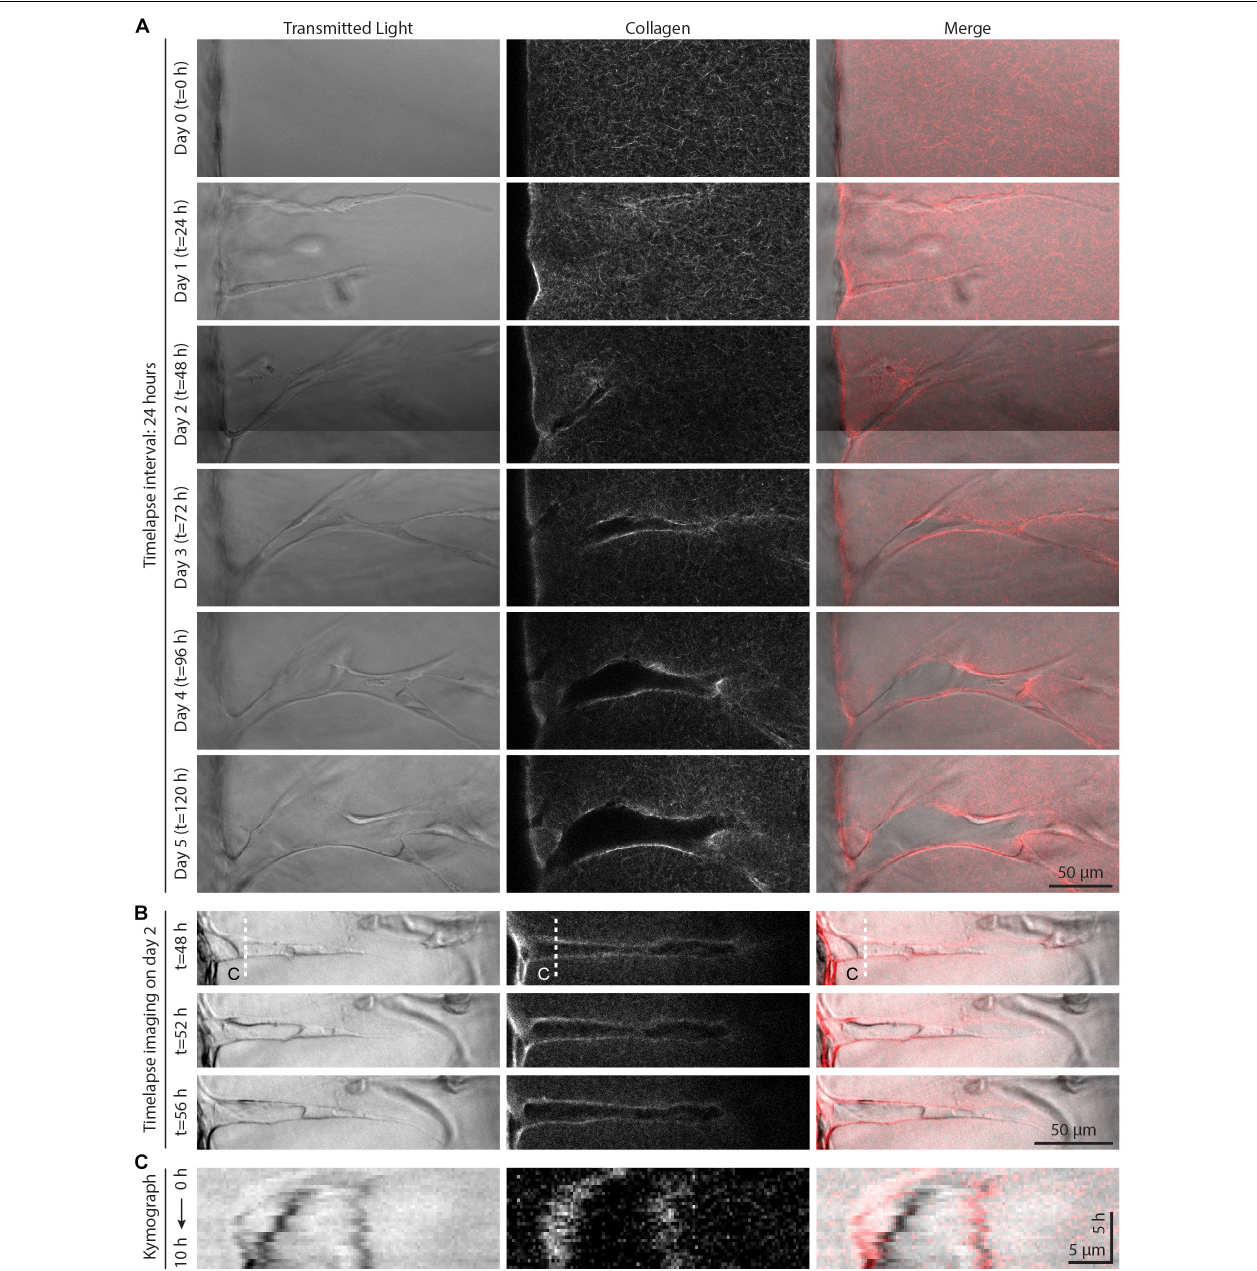
FIGURE 4 | Live time-lapse imaging reveals dynamic sprout and extracellular matrix (ECM) interactions. (A) Representative time course images (individual z-slices) of an invading sprout over 5 days with a frame interval of 24 h. Sprouts were cultured in 250 nM sphingosine 1-phosphate (S1P) and 50 ng ml − 1 phorbol 12-myristate 13-acetate (PMA) within 3 mg ml − 1 collagen hydrogel. (B) Representative time course images (individual z-slices) of an invading sprout over 8 h with a frame interval of 20 min (for full time-lapse series, see Supplementary Video 1 ). Sprouts were cultured in 250 nM S1P and 50 ng ml − 1 PMA within 3 mg ml − 1 collagen hydrogel, and imaging was initiated after 2 days in culture. (C) Kymographs taken along white dashed line indicated in panel (B)